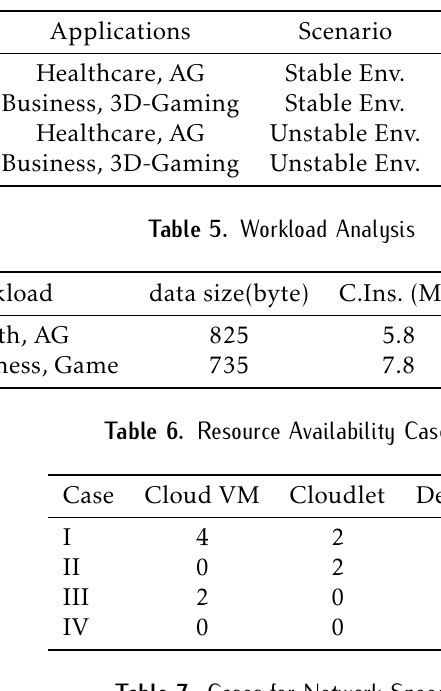
Table 7. Cases for Network